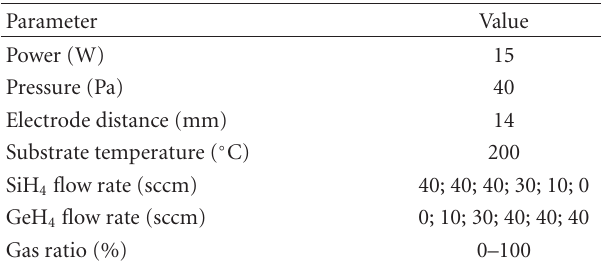
Table 1: The deposition conditions of SiGe